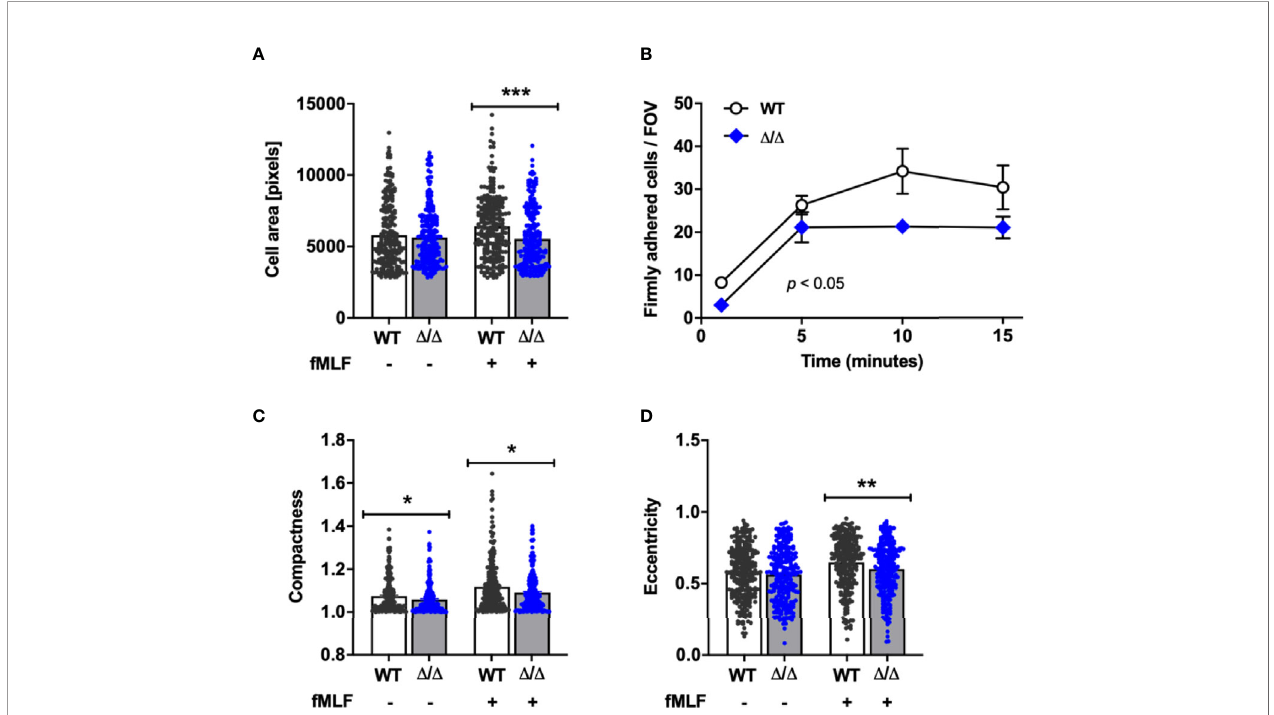
FIGURE 4 | SHIP2 regulates adhesion under fl ow and chemoattractant induced polarization. Bone marrow derived wild-type (WT) and Ship2 D / D ( D / D ) neutrophils were prepared and (A) plated onto glass coverslips in the presence of absence of 1 m M fMLF for 5 minutes prior to being fi xed. The area of GR1-positive cells obtained from 5 separate neutrophil preparations for a total of 240 cells per condition was measured using CellPro fi ler software. (B) Neutrophils were perfused at constant sheer stress through fl ow chambers coated with ICAM-1, rmE-selectin and rmCXCL1 as detailed in Materials and Methods. The graph shown combined results obtained from a minimum of three separate experiments. (C, D) Neutrophils from fi ve separate neutrophil preparations were plated onto glass coverslips in the presence of absence of 1 m M fMLF for 5 minutes prior to being fi xed. Compactness (C) and eccentricity (D) of GR1-positive cells were analyzed by CellPro fi ler to determine neutrophil polarization according to compactness ( C ; de fi ned as the mean squared distance of the object ’ s pixels from the centroid divided by the area, and where a full circle is attributed a value of 1 and larger values are given to irregular shapes), and eccentricity ( D ; the ratio of the distance between the foci of the ellipse and its major axis length, where 0 is a perfect circle, and 1 represents a straight line). p values were determined using the Mann-Whitney test (A, C, D) or an unpaired, two-tailed t test of the area under the graphs (B) . * p < 0.05; ** p < 0.01; *** p <